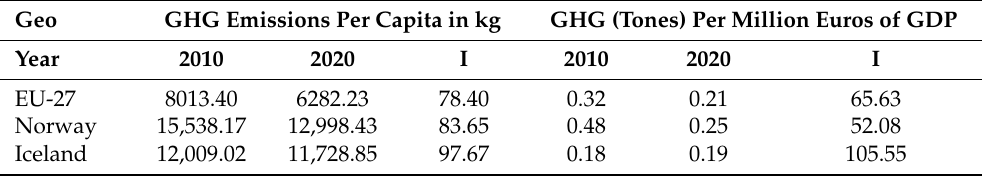
Table A1. Differences in GHG emissions between analysed countries.